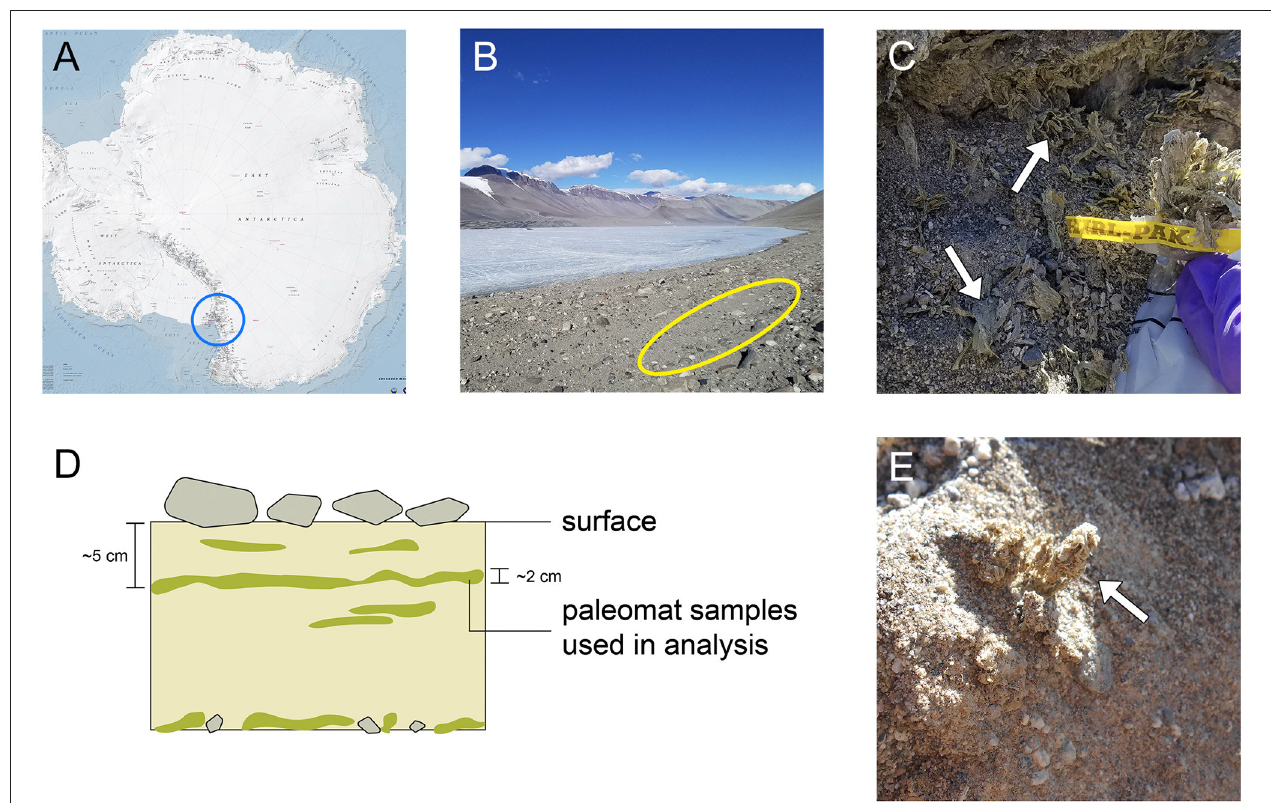
FIGURE 1 | Sampling site location and sample appearance. (A) Map of Antarctica, with the area containing the McMurdo Dry Valleys circled in blue. (B) Image of Lake Vanda and surroundings in Wright Valley; site where the mats were collected is indicated by the yellow oval. (C) Image of paleomat in excavated sampling site, with a whirlpack for scale. The mat was collected ∼ 5cm below surface. (D) Schematic of paleomat distribution in areas where they are found. (E) Close-up of Lake Vanda